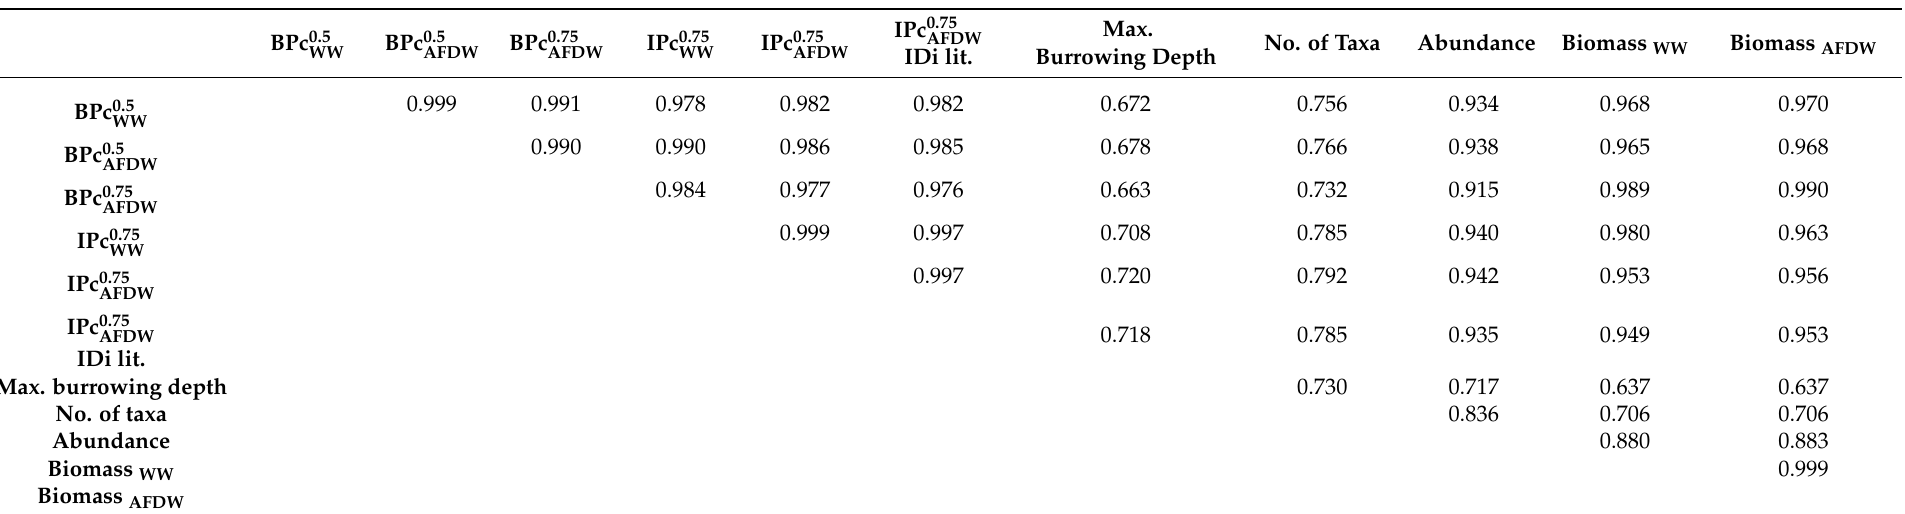
Table 5. Spearman’s correlation coefficients of biological parameters from all sampling sites. Both indices were calculated using different exponents (0.5 or 0.75) and two types of animal biomass—wet formalin mass (WW) or ash free dry mass (AFDW). Significance level for all correlations was p <